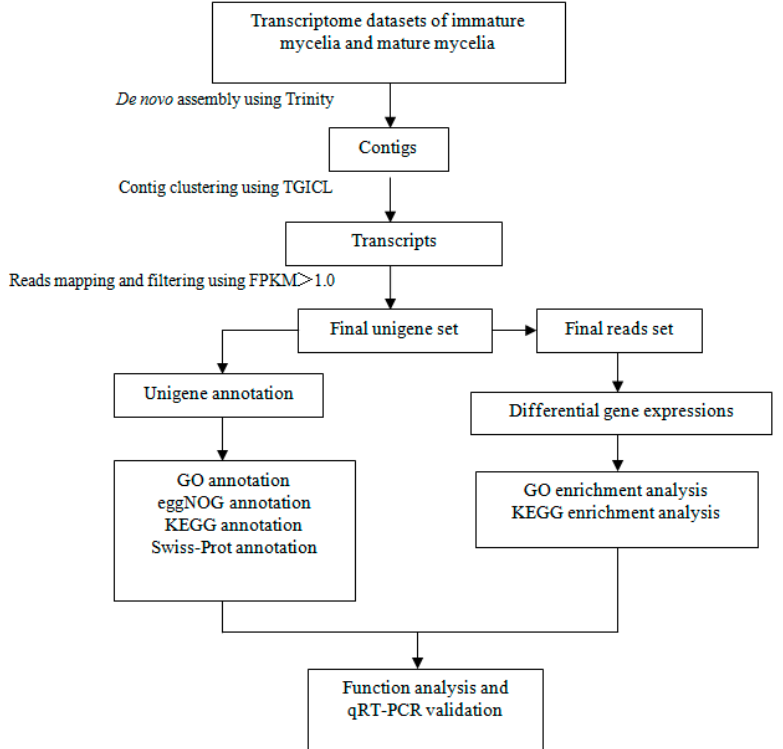
Figure 2. Analytical framework of the P. tuoliensis mycelia transcriptome. Raw reads were filtered and then de novo assembled into contigs by Trinity. Unigenes were obtained by clustering the contigs with TGICL. FPKM values were calculated for each of the unigenes, and only unigenes with FPKM > 1.0 were used for further analyses and annotation against the public databases.